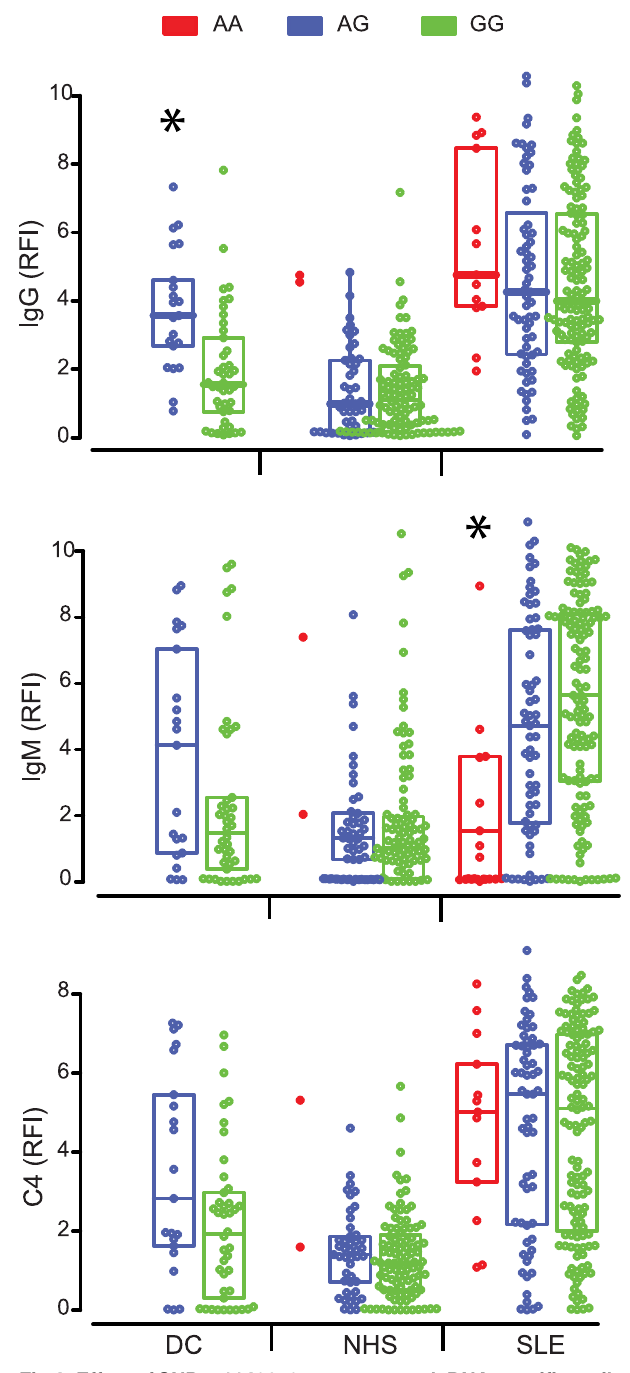
Fig 4. Effect of SNP rs1143679 genotype on dsDNA specific antibody levels and C4 deposition. Binding of IgG, IgM and C4 to dsDNA was determined by functional antibody profiling analysis. Individuals within the study groups were classified based on their genotype. Boxes show interquartile ranges, horizontal lines stand for median. Asterisks indicate statistically significant (p < 0.05) difference from the GG genotype. AA genotype carriers in the NHS group were excluded because of the low number of